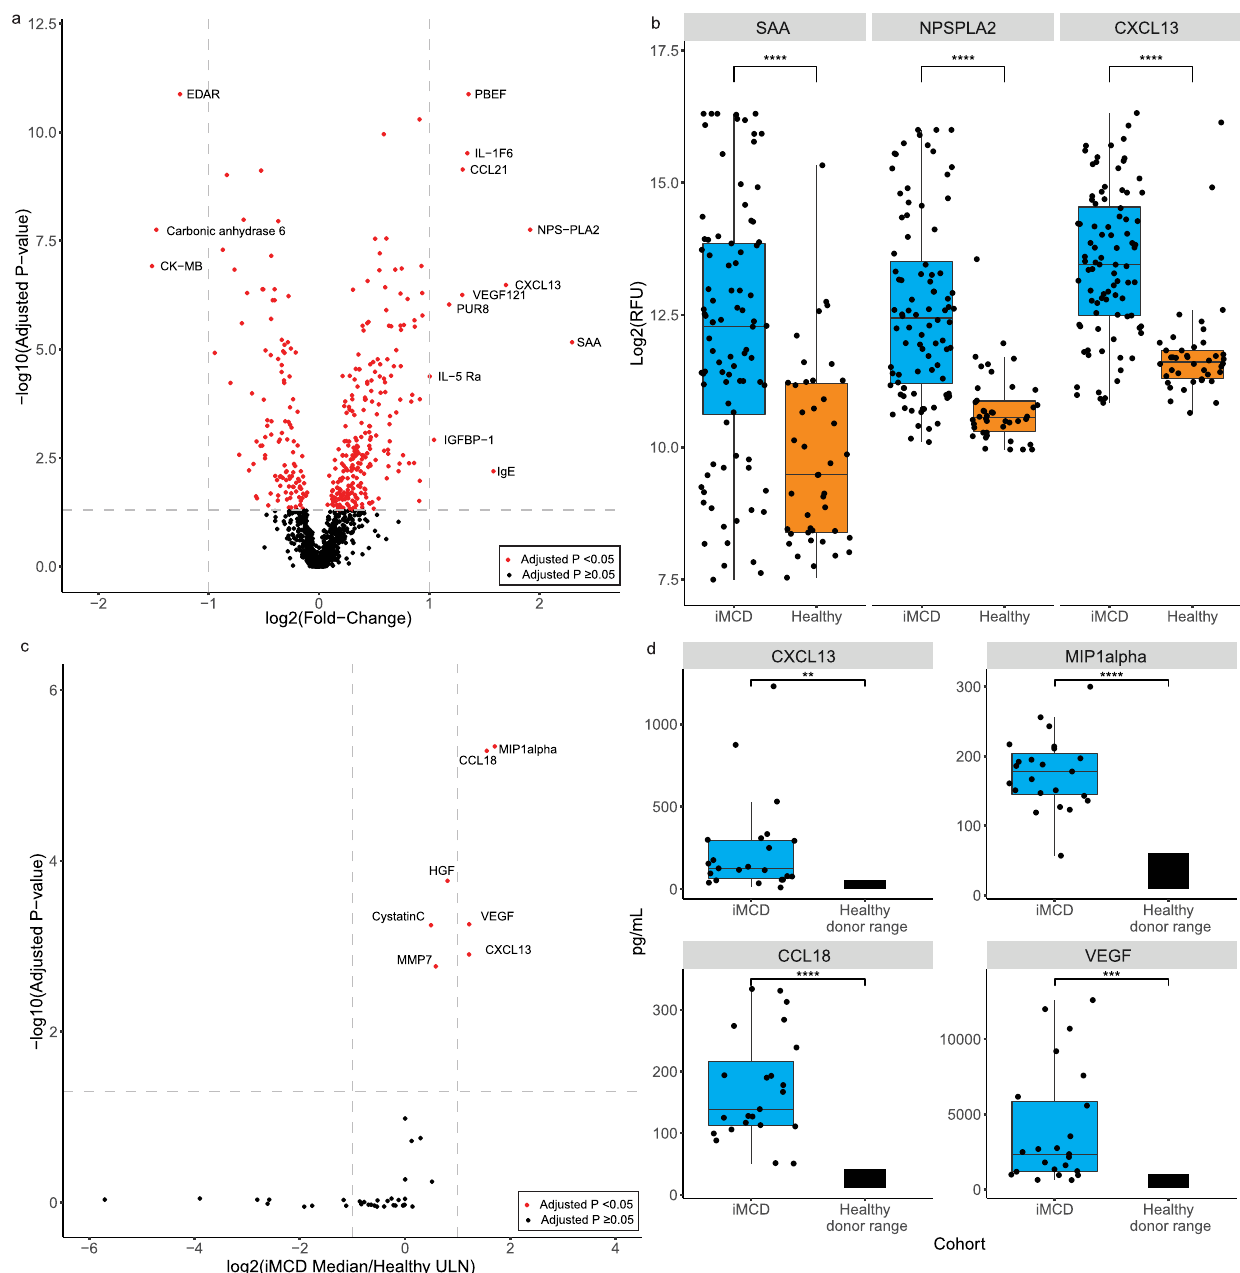
Fig. 1 | Differential expression of proteins between iMCD and healthy controls demonstrates increased CXCL13 across cohorts. a Volcano plot visualization of differentially expressed proteins between iMCD ( n =88) and healthy donors ( n = 42). To detect differences in the proteome, linear regression models comparing iMCD to healthy, adjusted for age and sex, were run on each analyte. Results were adjusted by Benjamini & Hochberg method with alpha <0.05. We identi fi ed 251 upregulated proteins and 118 downregulated proteins in iMCD relative to healthy. Signi fi cant proteins that are >2-fold upregulated are labeled. Exact P values are listed in Supplementary Data 1 and the source data fi le. b The three most upregu- lated proteins (log2 transformed) in iMCD ( n =88) relative to healthy controls ( n =42) are visualized by boxplot. c To validate the proteomic changes identi fi ed against healthy individuals, we compared samples obtained from an independent validationiMCDcohort( n =23)totheexpectedupperlimitinahealthypopulation using an orthogonal platform. The median analyte level in iMCD was compared to the 97.5th percentile of the expected healthy range using a one-sided Mann – Whitney U -test with adjustment by Benjamini & Hochberg, alpha <0.05. A one-sidedvolcanoplotofthe40overlappingproteinsquanti fi edisshown.Proteins with median levels con fi rmed to be signi fi cantly elevated in iMCD over the 97.5th